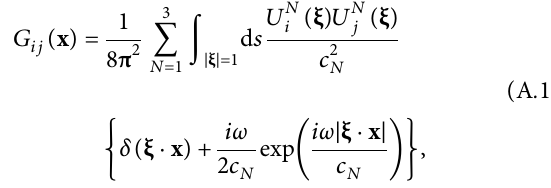
and ρ and dynamic effective modulus L 11 33